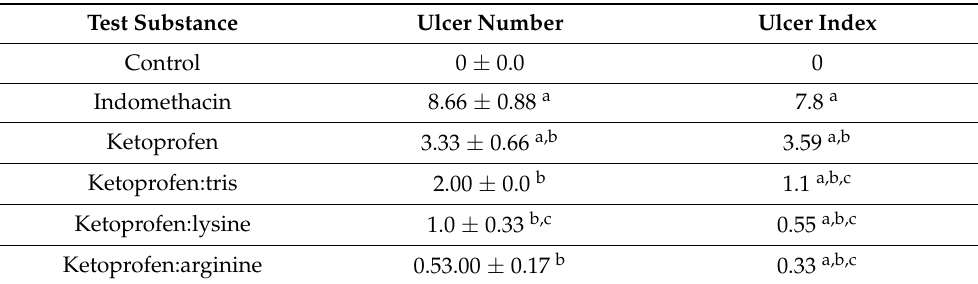
Table 3. Ulcerogenic potential (number of ulcers) and ulcer indices for the positive control (in- domethacin), ketoprofen (K), K:lysine, K:arginine:K:tris coprecipitated